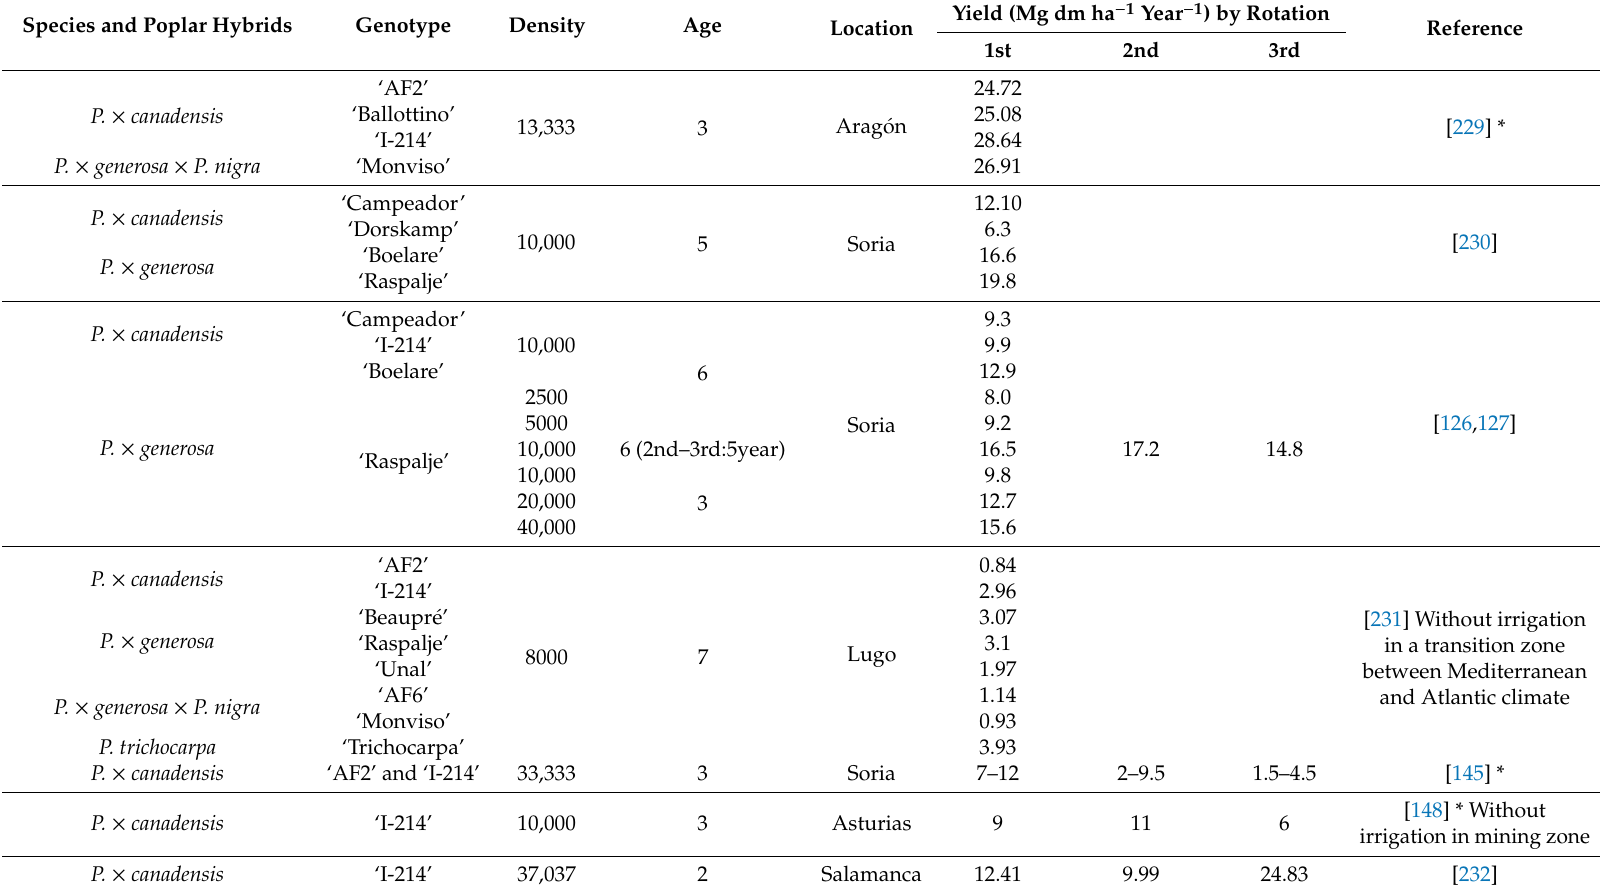
Table 3. Di ff erent examples of the biomass yield (Mg dm ha − 1 year − 1 ) per genotype, age, and rotation in poplar short rotation plantations in Spain under Mediterranean